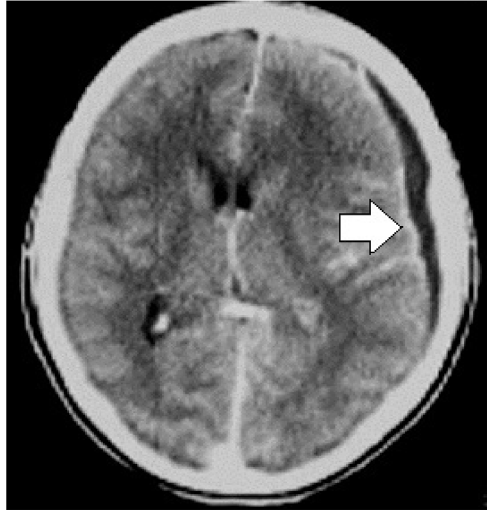
Figure 1 Axial CT scan showing subdural